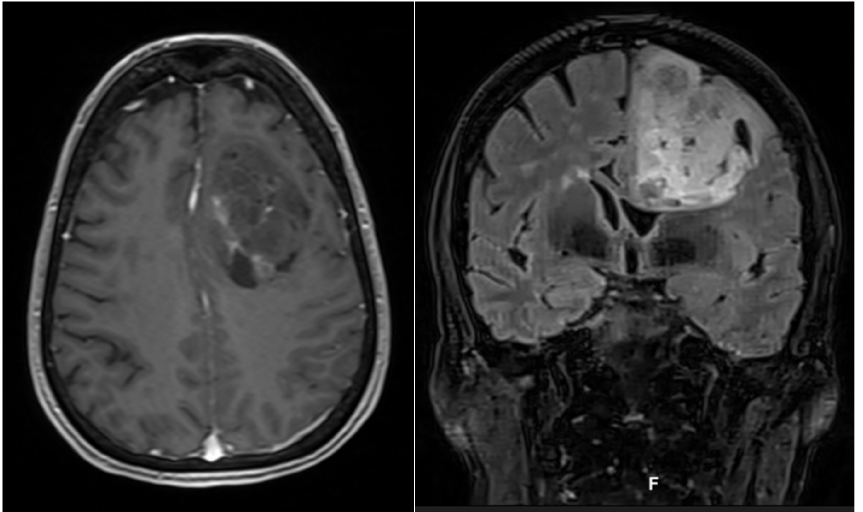
Figure 7. Axial contrast enhanced T1-weighted MRI ( left ) and coronal T2 flair ( right ) sequences showing a frontal left mass.